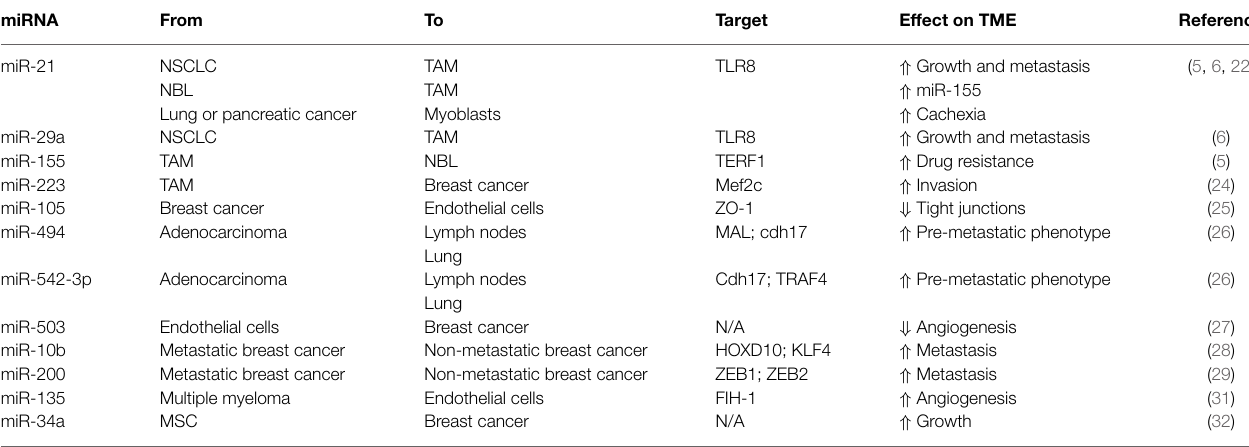
TABLE 1 | Exosomal microRNAs shuttling between cancer cells and tumor microenvironment . miRNA From To